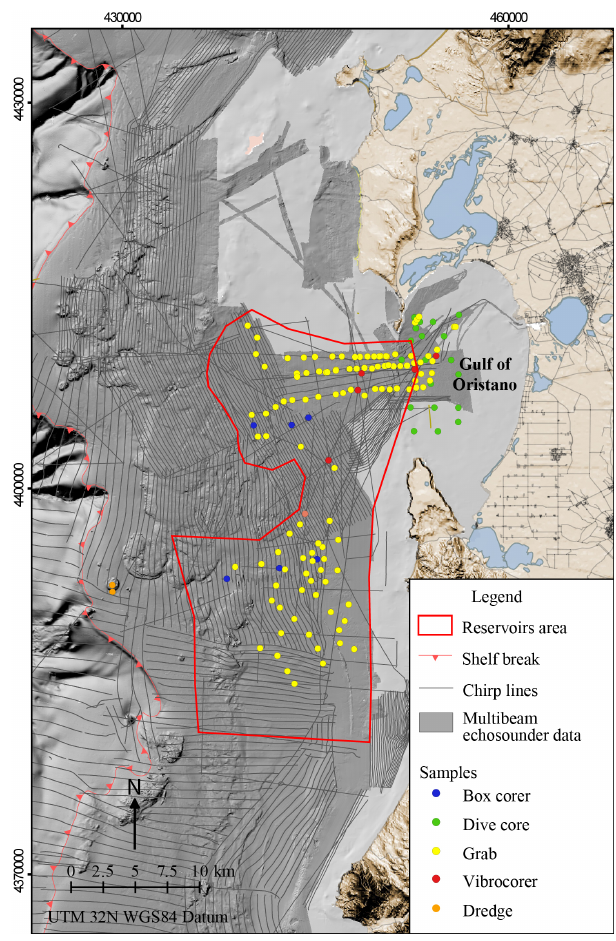
Figure 2. Locations of acquired data